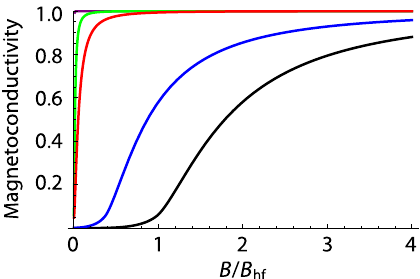
FIG. 8. Results of the two-site model for various correlation lengths of the inhomogeneous field: Organic magnetoconductiv- ity, caused by fringe fields of differing correlation lengths, computed from the analytic function g in Ref. [30]. Here, a magnetoconductivity of 1 corresponds to the high-field limit, and one of 0 corresponds to the zero-field magnetoconductivity for a spatially uncorrelated inhomogeneous field. The black curve is the result for an uncorrelated field, and the blue, red, green, and purple curves are for 2-, 5-, 10-, and 50-nm correlation